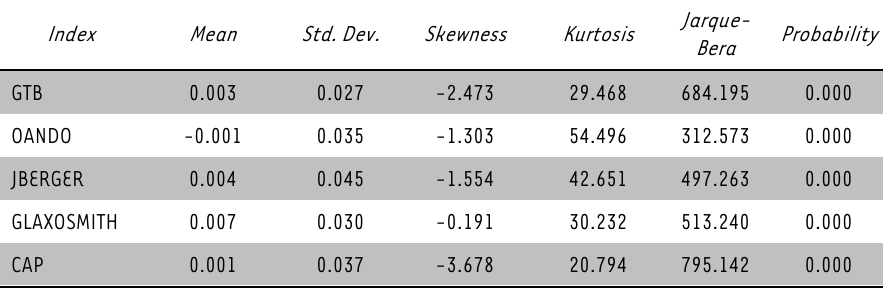
TABLE 3: Summary Statistics of the index returns